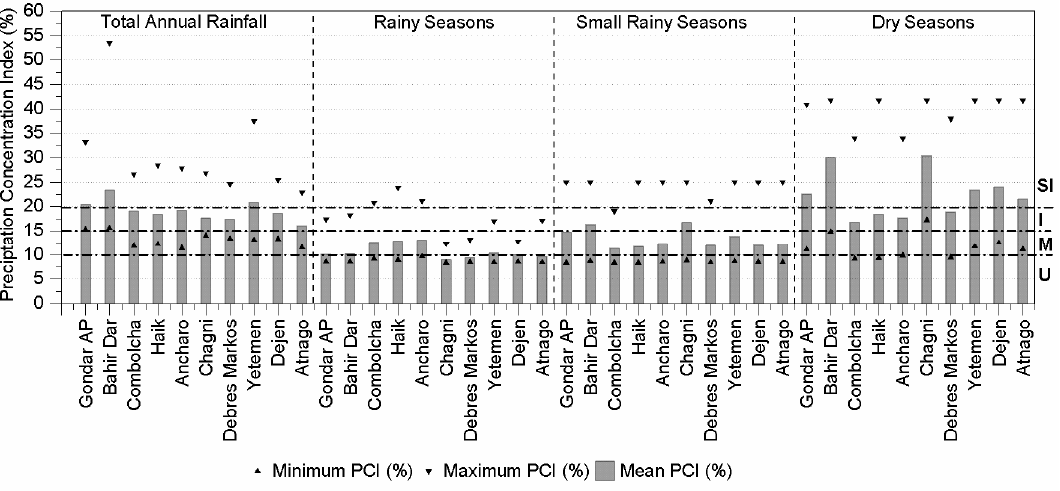
Figure 5. Annual and seasonal Precipitation Concentration Index (PCI) values for UBNB showing PCI categories borderlines (dash-dot lines).